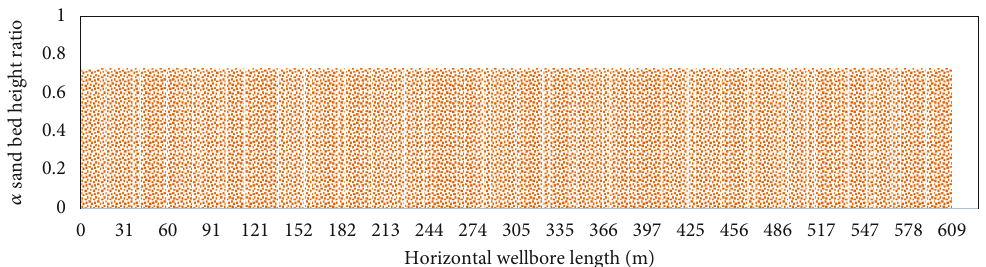
Figure 2: Calculation result for α wave sand bed